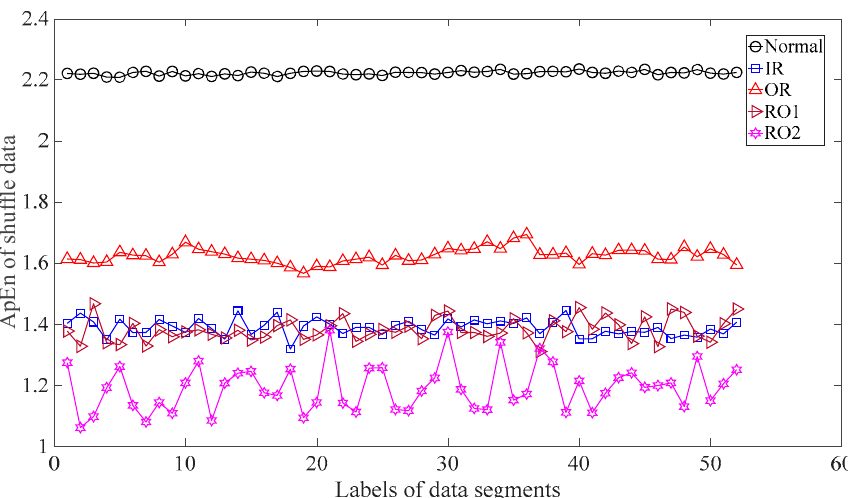
Figure 18. ApEn of the shuffle versions of the five types of roller-bearing vibration data.